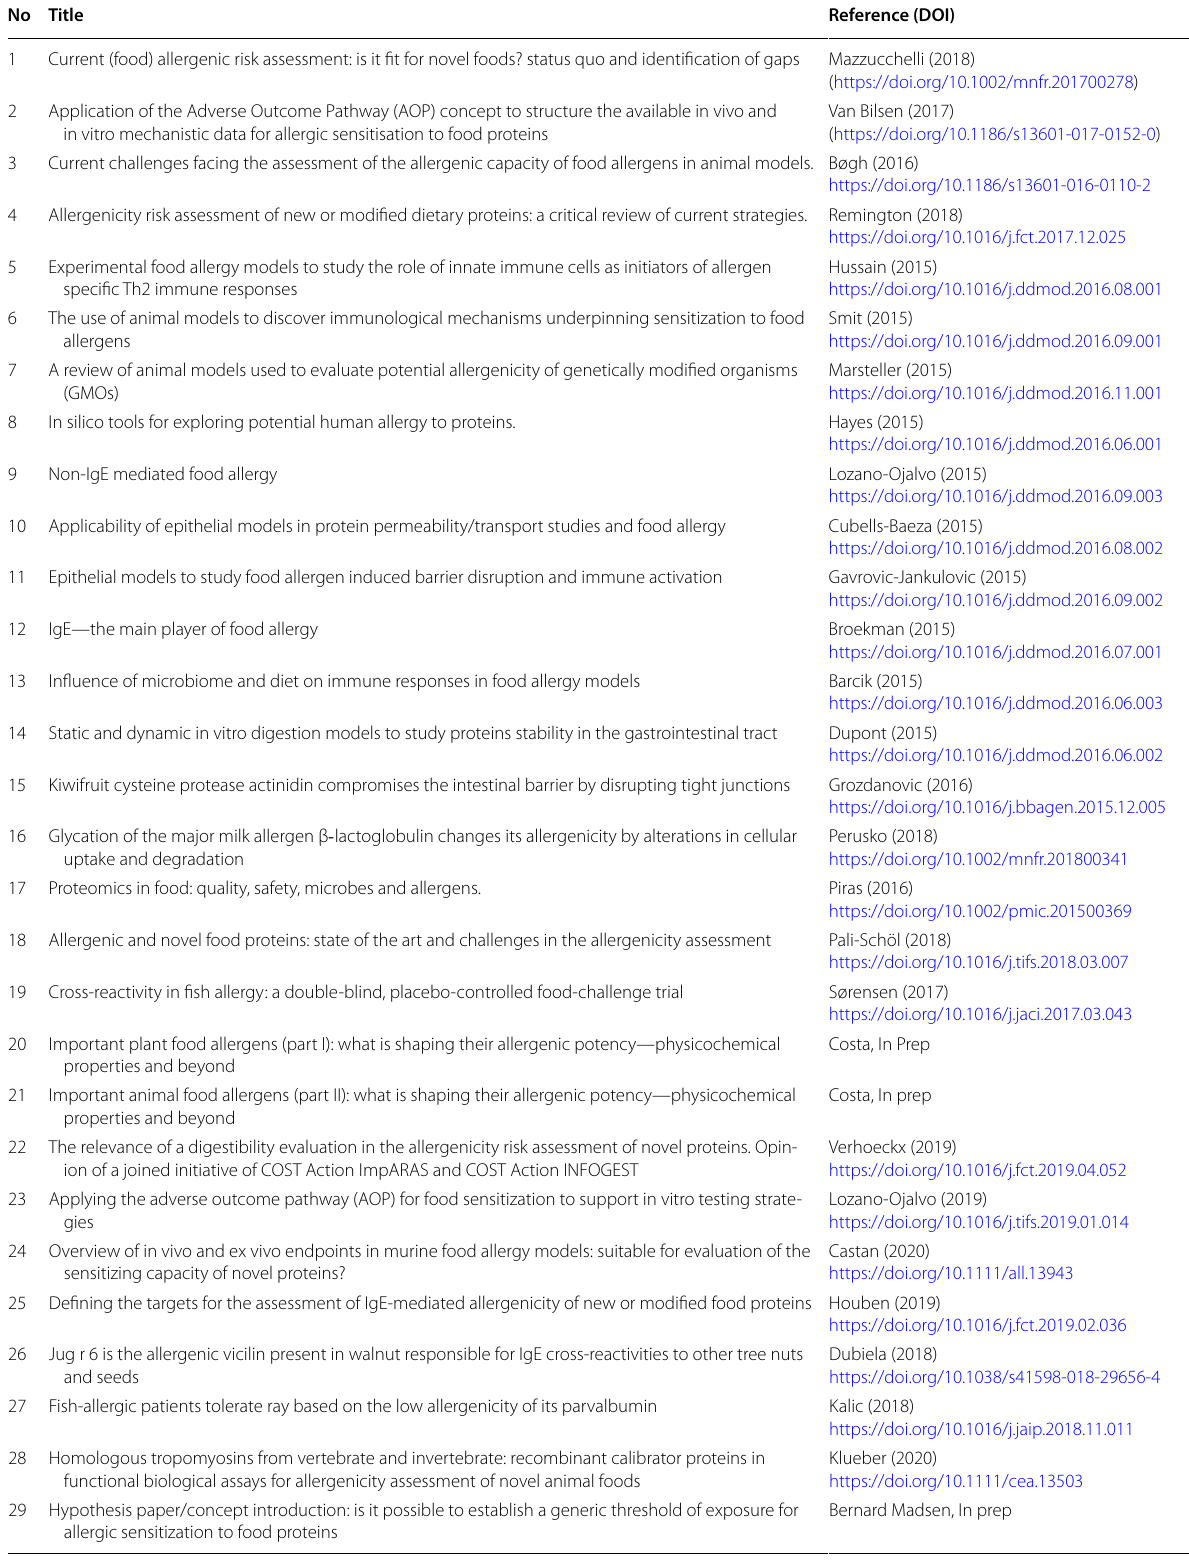
Table 5 List of most relevant peer-reviewed papers from the ImpARAS network No Title Reference